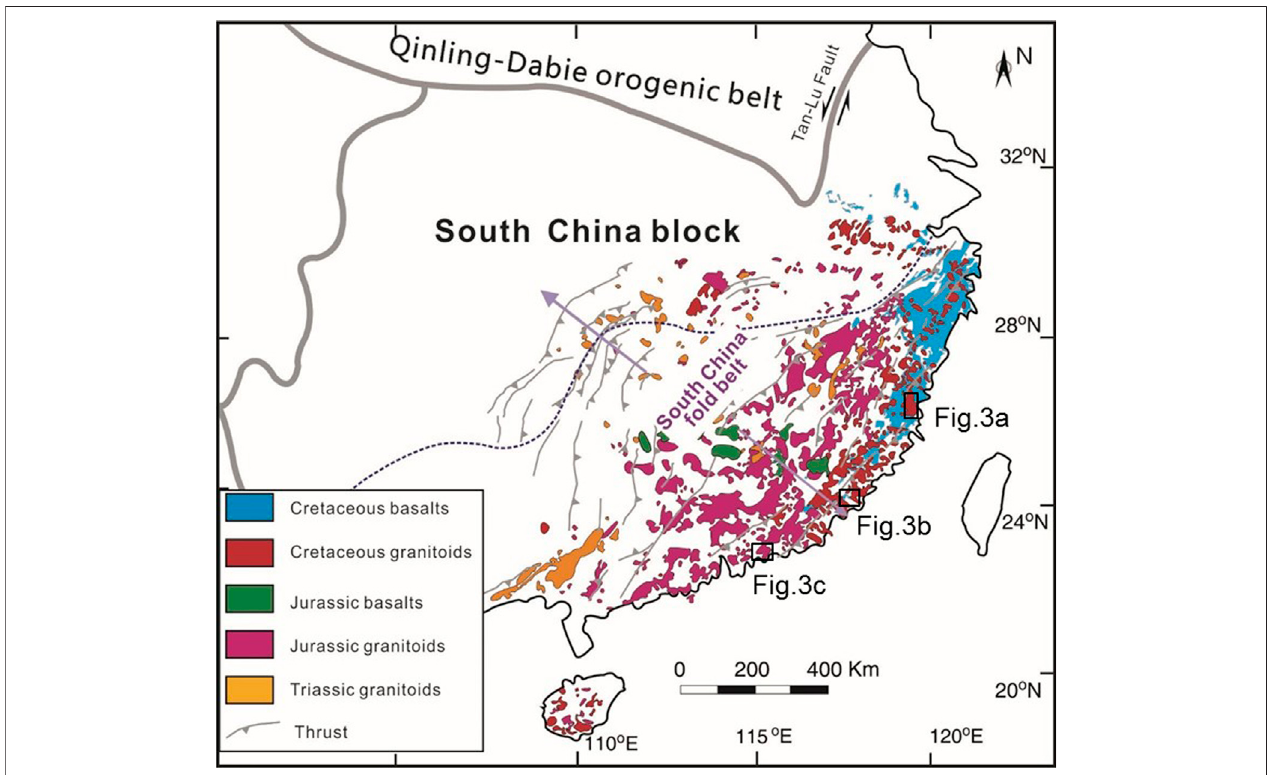
FIGURE 1 | The granite distribution map of the study area (Modi fi ed after Zhang et al., 2020).